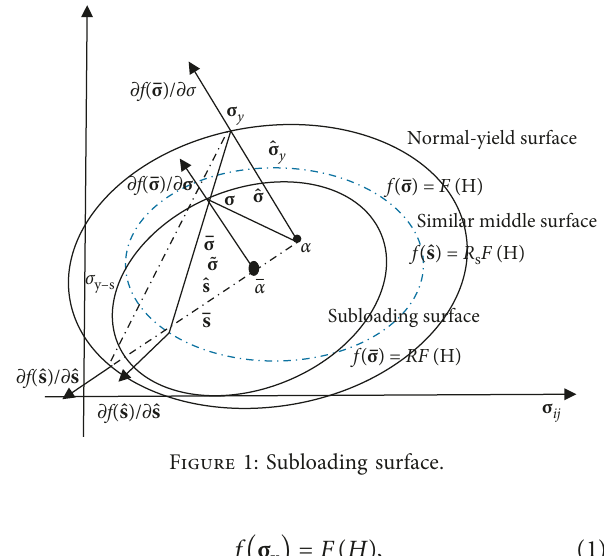
Figure 1: Subloading